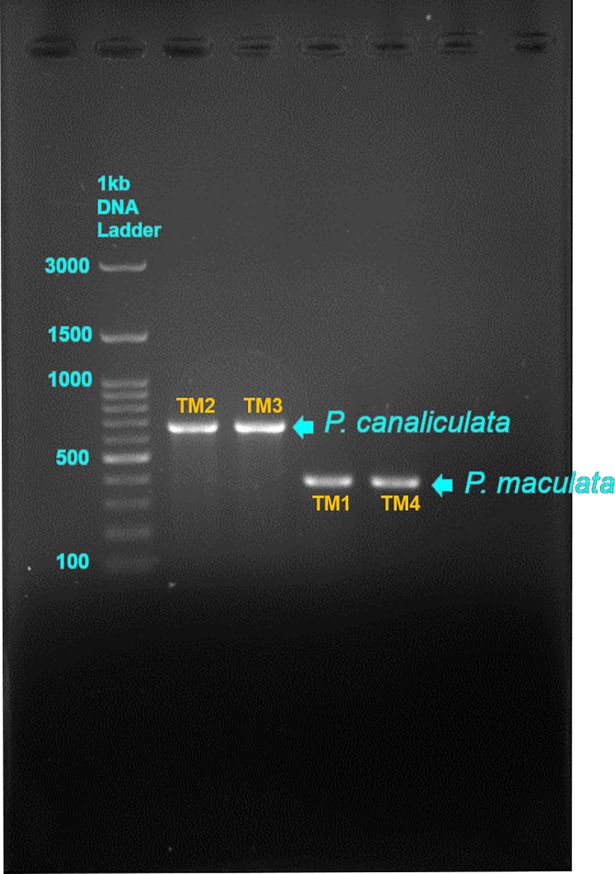
Gel electrophoresis image which shows length differences of the amplified genomic DNA fragments of P. canaliculata and P. maculata using the mitochondrial primers of the cytochrome c oxidase subunit (COI) gene PcanCOI (F) and PinsCOI (F), HCO 2198 (R).Amplified fragments were 666 bp and 390 bp respectively.